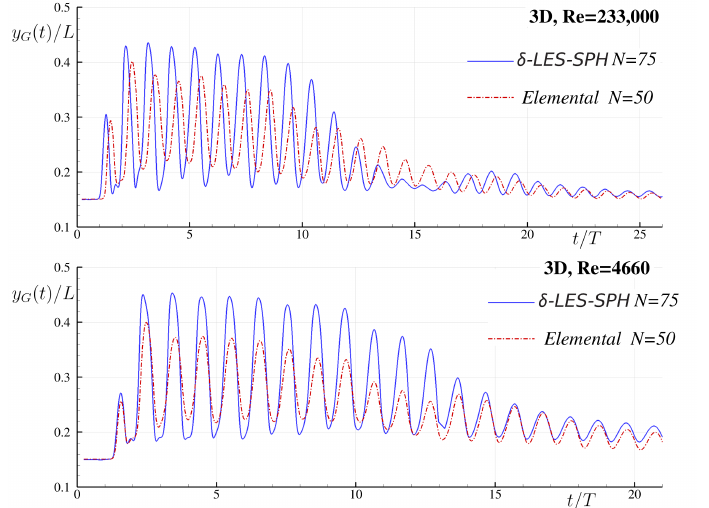
Figure 34. Time history of the vertical position of the fluid center of mass y G ( t ) evaluated by the SPH-Flow and Elemental solvers in a 3D framework. ( Top ) water test-case. ( Bottom ) oil